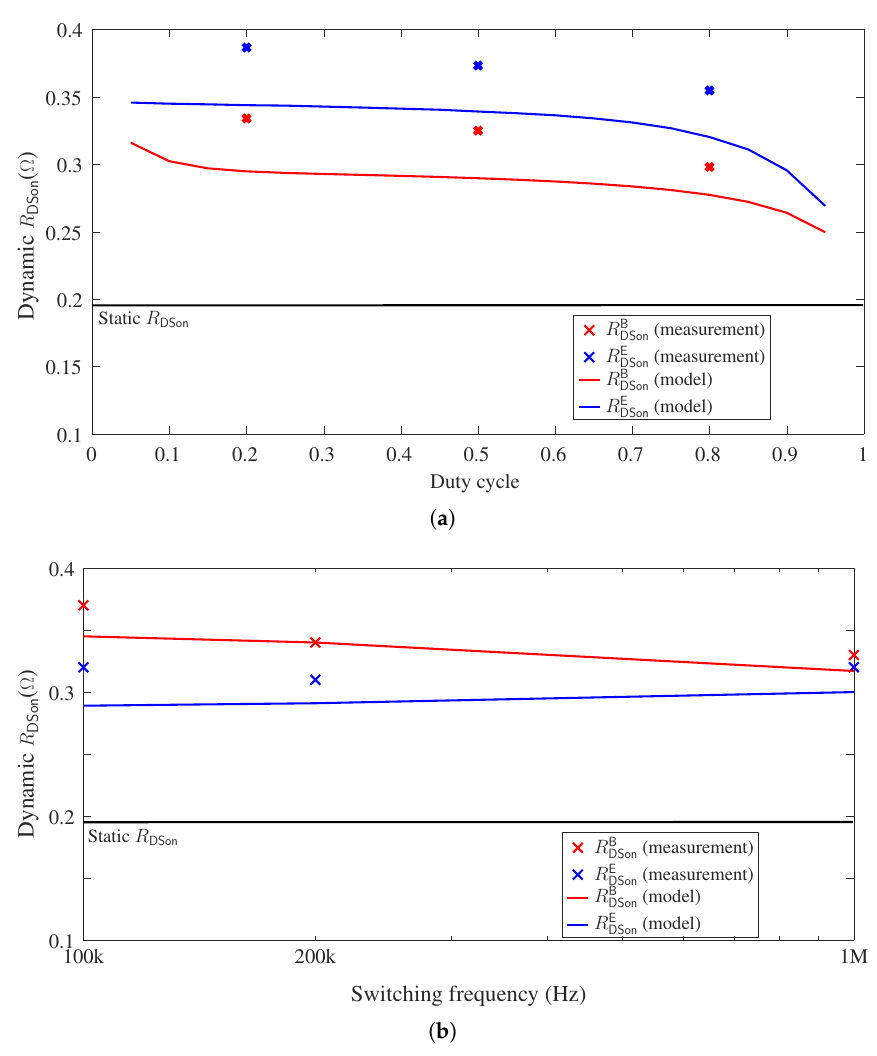
Figure 15. GaN-HEMT dynamic R DSon value of different operation conditions: ( a ) different duty cycles ( f sw = 100 kHz) and ( b ) different switching frequencies (D =